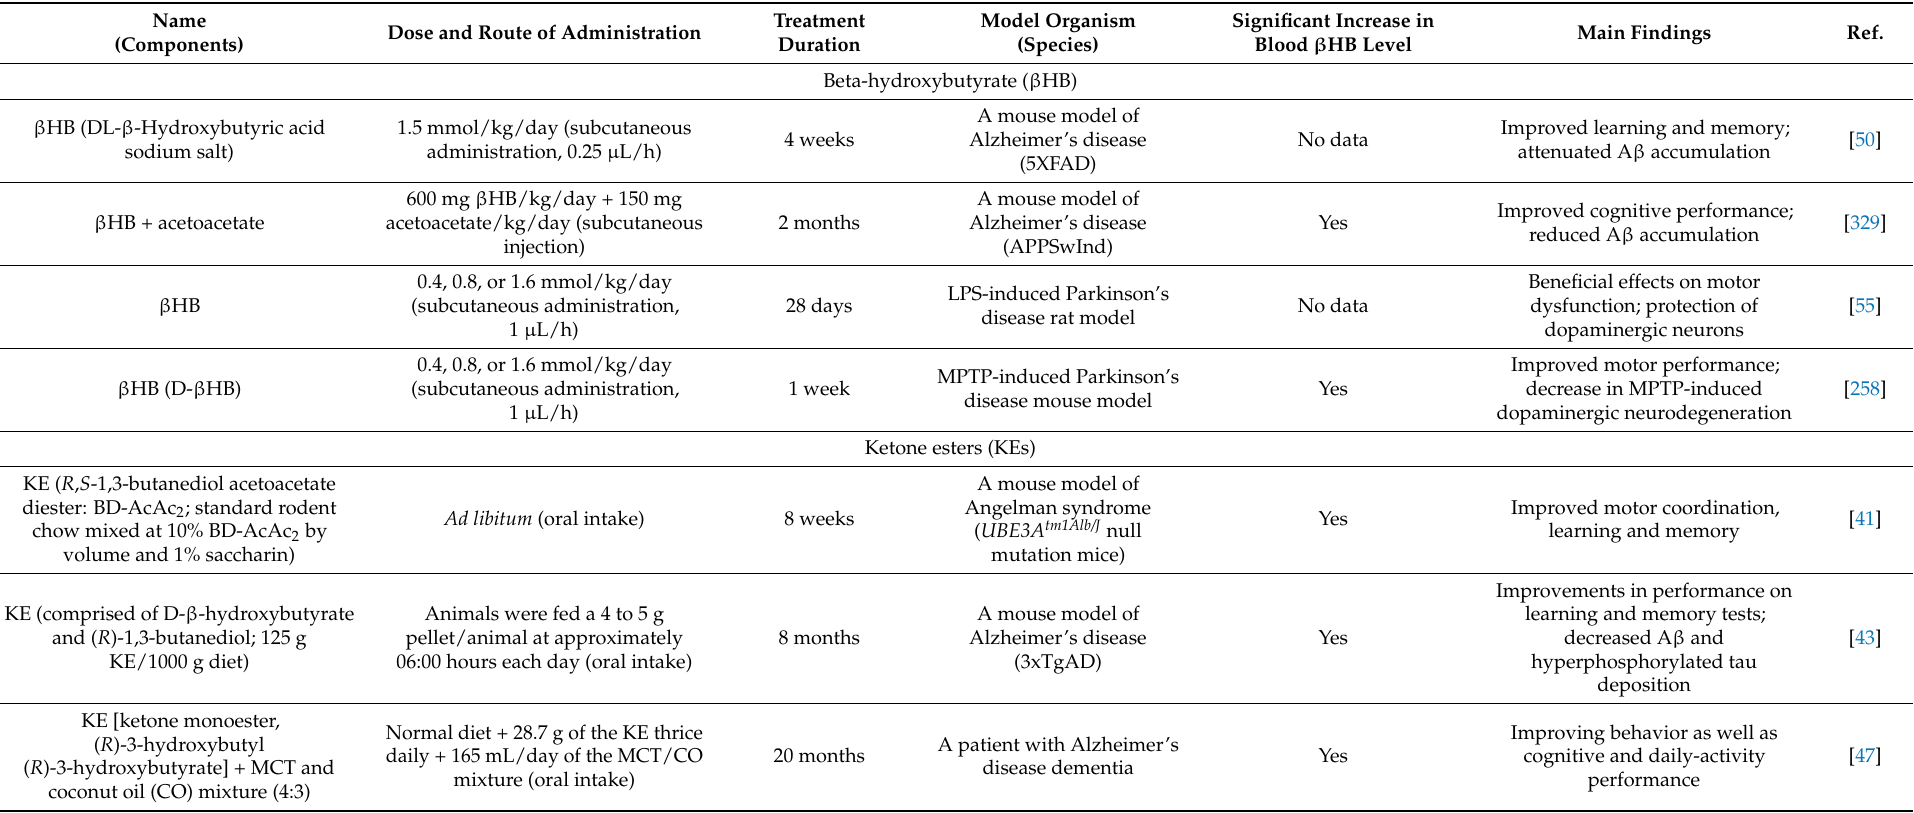
Table 1. Beneficial effects of beta-hydroxybutyrate ( β HB), ketone esters (KEs) and medium chain triglycerides (MCTs) on neurodegenerative diseases as well as impaired motor, memory and learning functions in in vivo